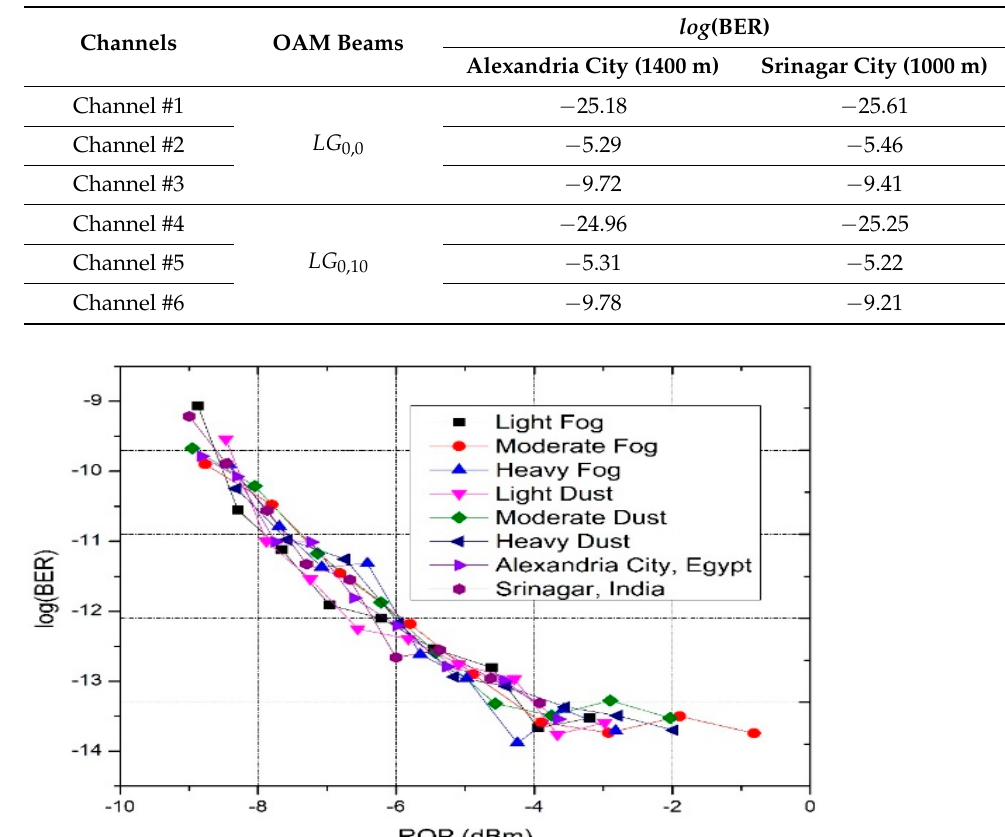
Table 8. Log (BER) values at maximum computed FSO link for our proposed model in Alexandria and Srinagar cities.